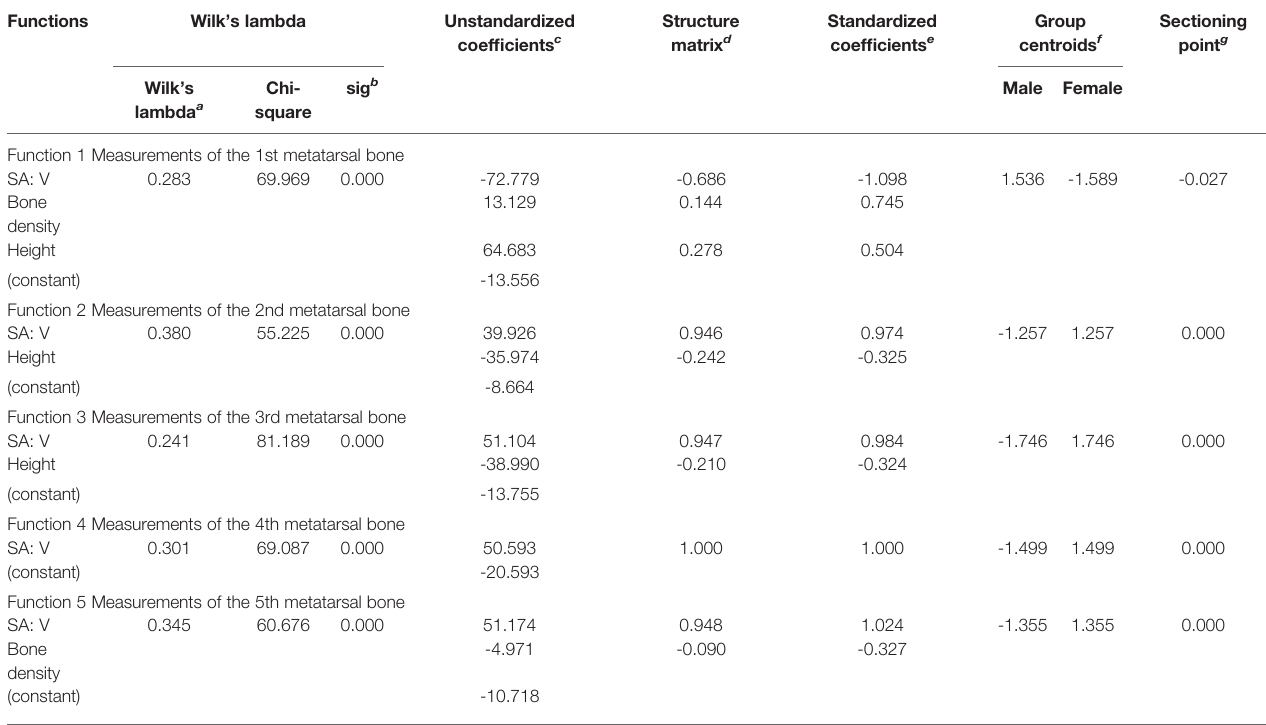
TABLE 8A | Stepwise discriminant function analysis for left metatarsal bone.